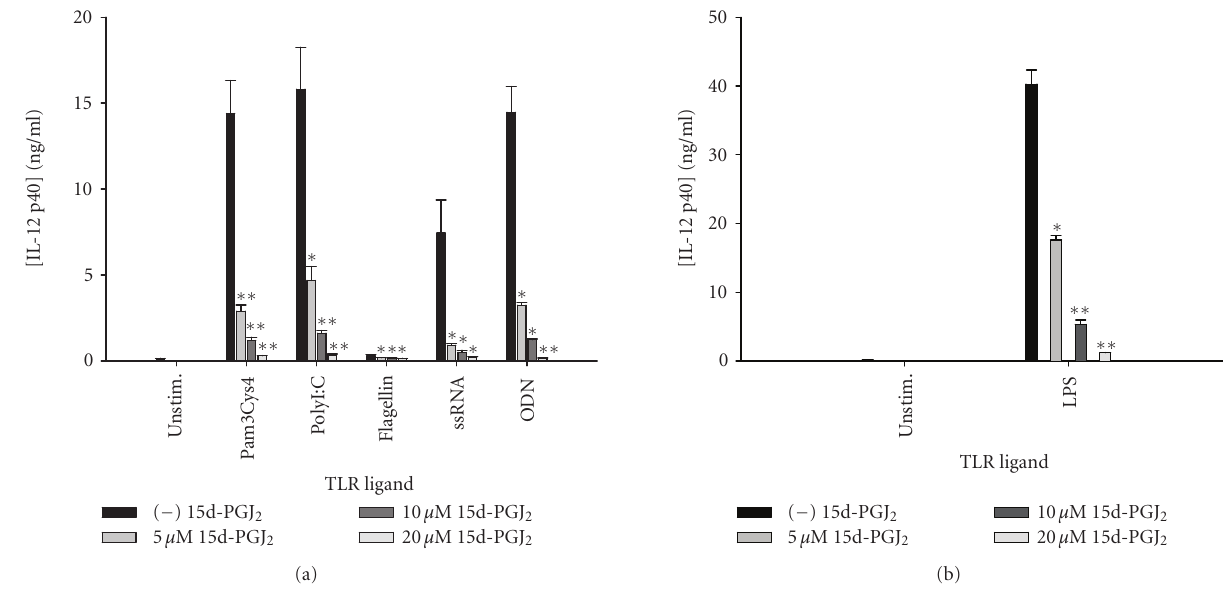
Figure 10: 15d-PGJ 2 is a global inhibitor of astrocytic IL-12 p40 release following TLR ligand exposure. Primary astrocytes were plated at 1 × 10 5 cells/well in 96-well plates and incubated overnight. The following day, cells were pretreated for 1hour with the indicated concentrations of 15d-PGJ 2 prior to the addition of TLR ligands. Cell-conditioned supernatants were collected at 24 hours following TLR ligand exposure, whereupon IL-12 p40 levels were determined by ELISA (a) and (b). Significant di ff erences between astrocytes treated with TLR ligands alone versus TLR ligands + 15d-PGJ 2 are noted with asterisks ( ∗ P < . 05; ∗∗ P < . 001). Results presented are representative of two independent